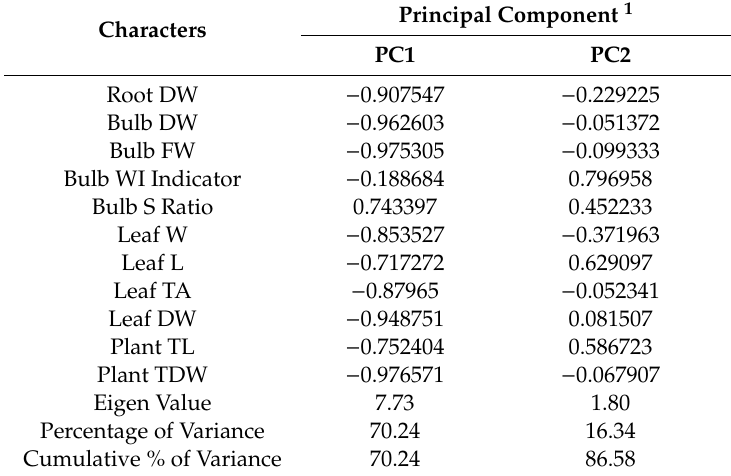
Table 4. Component loading of 11 traits, eigen values, proportion of total variability represented by the first two principal components (PC), cumulative variability in narcissus bulbs.